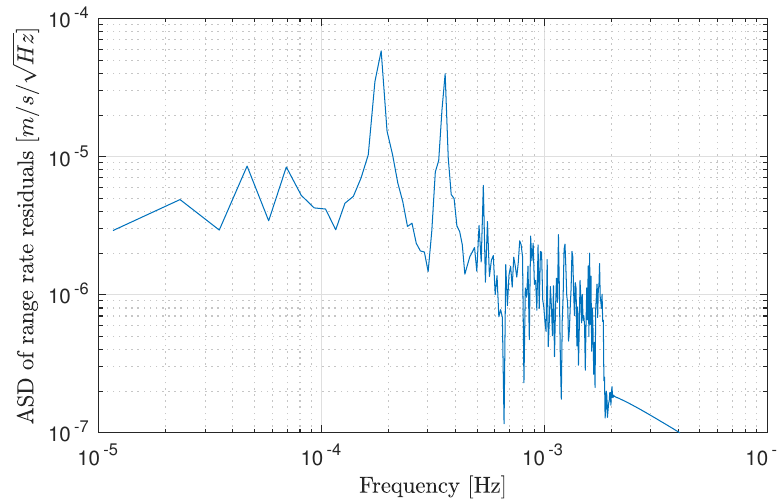
Figure 7. Amplitude spectral density of range rate residuals for Day 1 after the sixth iteration.